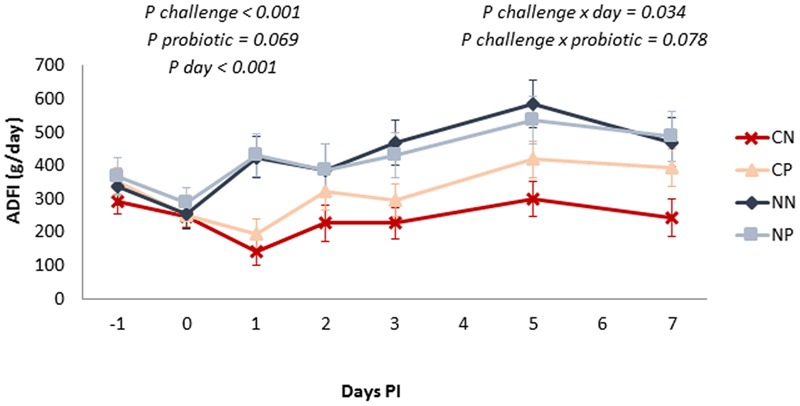
Average daily feed-intake evolution along the post-inoculation (PI) period. Treatments: CN, challenged + no probiotic; CP, challenged + probiotic; NN, no challenge + no probiotic; NP, no challenge + probiotic. n = 8 for groups CN and CP, n = 4 for groups NN and NP. Interactions only included when significant. Bars represent the standard error of the LS-Means.